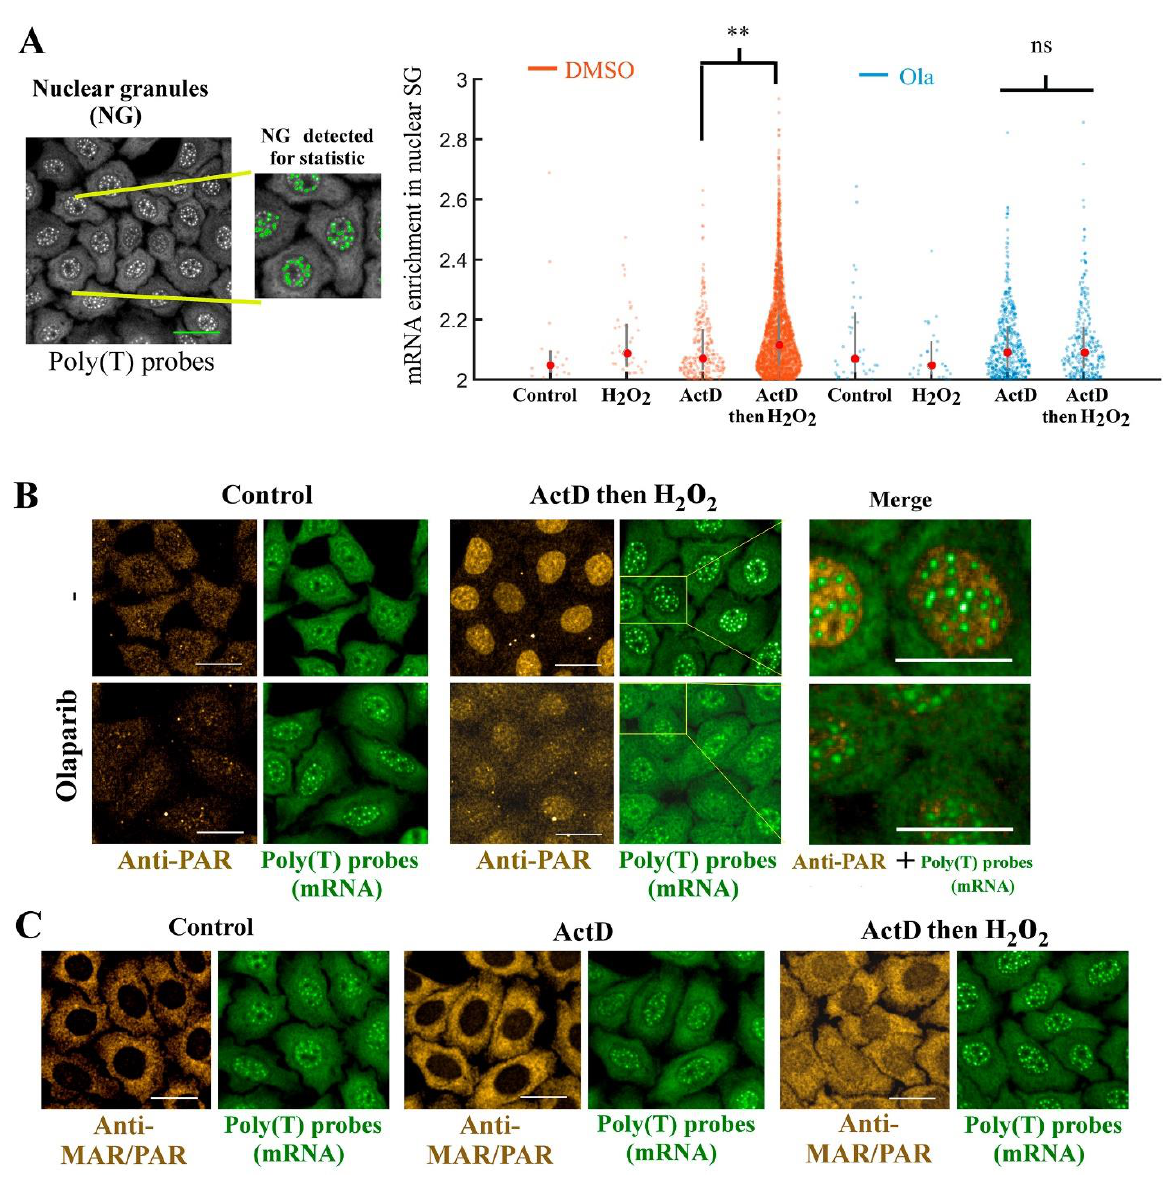
Figure 4. PAR is not detected in mRNA-rich nuclear granules even after PARP1 activation. ( A ) Left panel : Automatic detection scheme based on the Harmony software (imager, Opera Phenix plus). Right panel : mRNA enrichment in nuclear granules detected under indicated conditions. Scale bar: 10 μm. Red dots represent the mean value of the data, ns: not significant. ( B ) The presence of nuclear mRNA-rich condenses in the nucleus was detected in HeLa cells for indicated conditions (300 µM H 2 O 2 for 30 min; 4 µM actinomycin D for 1 h prior and during indicated treatment; 10 µM olaparib for 1 h prior to and during indicated treatments). The mRNA enrichment (in situ hybridization with cy3-labelled poly(dT) probes) in the nuclear granules relative to the nucleoplasm was measured, as well as the number of nuclear granules (in quadruplicate). A significant increase in both SG number and fluorescence intensity was detected after combined ActD and H 2 O 2 treatment; this phenotype was antagonized by olaparib. **, p < 0.01; t test. Green: mRNA (poly(T) probes). Gold: anti-PAR ant ibody. Scale bar: 10 μm. ( C ) Representative images of HeLa cells after indicated treatments (those indicated in ( B )). Note the absence of co-localization between mRNA in nuclear SGs and anti-PAR antibody or anti-MAR/PAR antibody, despite the presence of PAR and MAR/PAR in the nucleus after PARP1 activation by H 2 O 2 for 30 min. Gold: anti-PAR/MAR antibody. Green: mRNA (in situ hybridization with cy3- labelled poly(dT) probe. Scale bar: 10 μm.